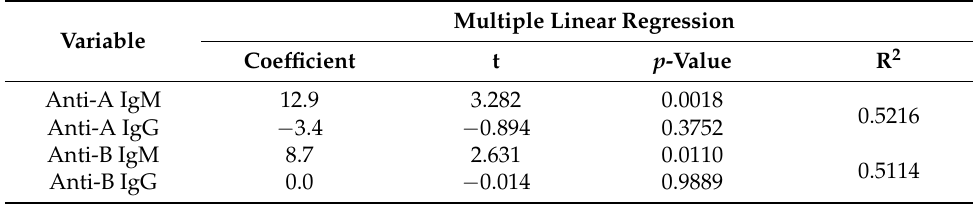
Table 2. Multiple linear regression analysis results of hemolysis (%) related to ABO Ab titers.